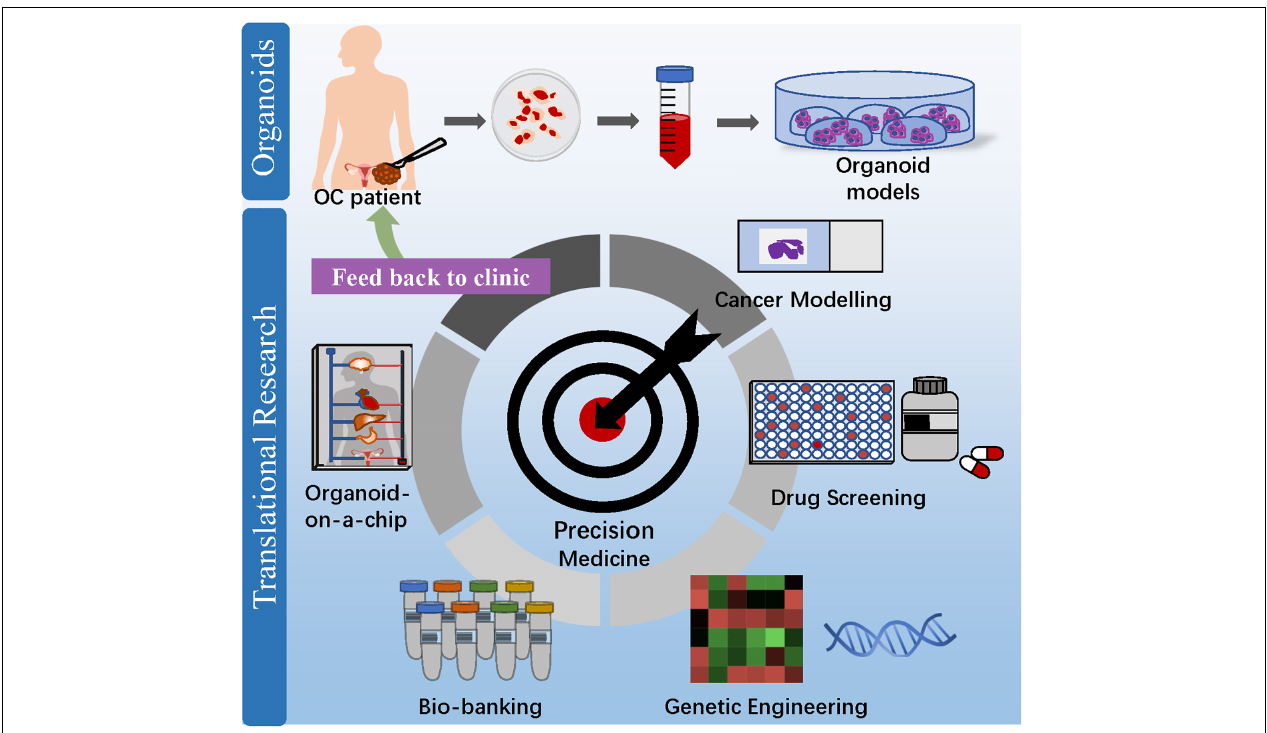
FIGURE 3 | Clinical application of OC organoids from bench to bedside. Patient-derived organoids can be used for cancer modeling, drug screening, biobanking, and organoid-on-a-chip, which aim at maximizing drug efficacy and enabling precision medicine to benefit OC